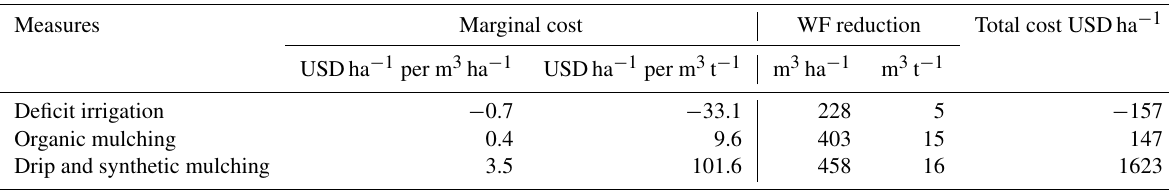
Table G6. Marginal cost and WF reduction per subsequent measure in the MCC for WF reduction in potato production for the baseline of sprinkler irrigation combined with full irrigation and no